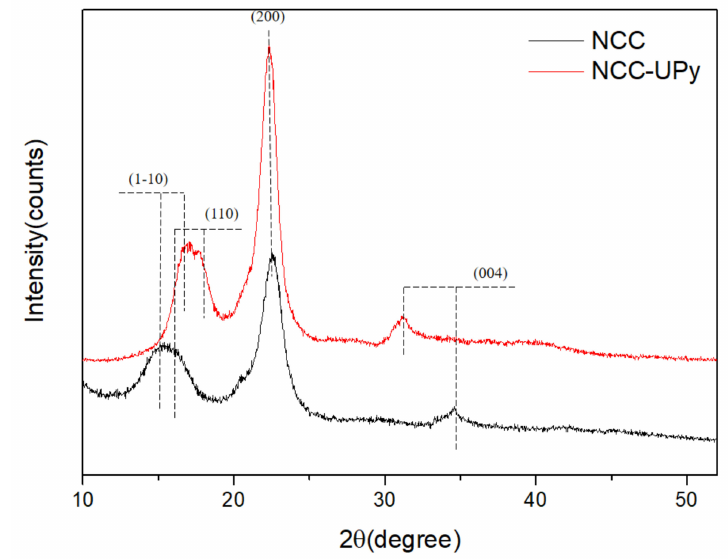
Figure 8. XRD spectra of NCC and